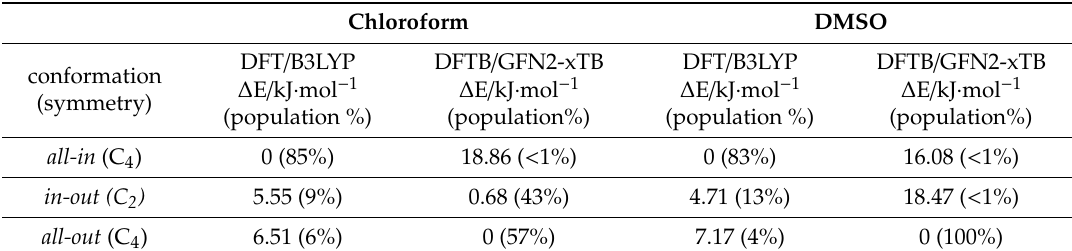
Table 1. Relative energies of conformers of 4 calculated by DFT / B3LYP and DFTB / GFN2-xTB and their theoretical populations at 298 K.